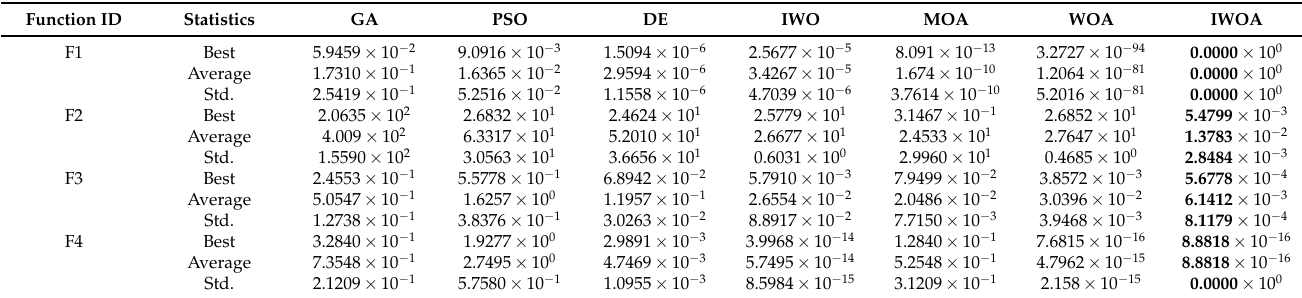
Figure 4. Simulation experiment results. Table 3. Results of algorithms on basic benchmark